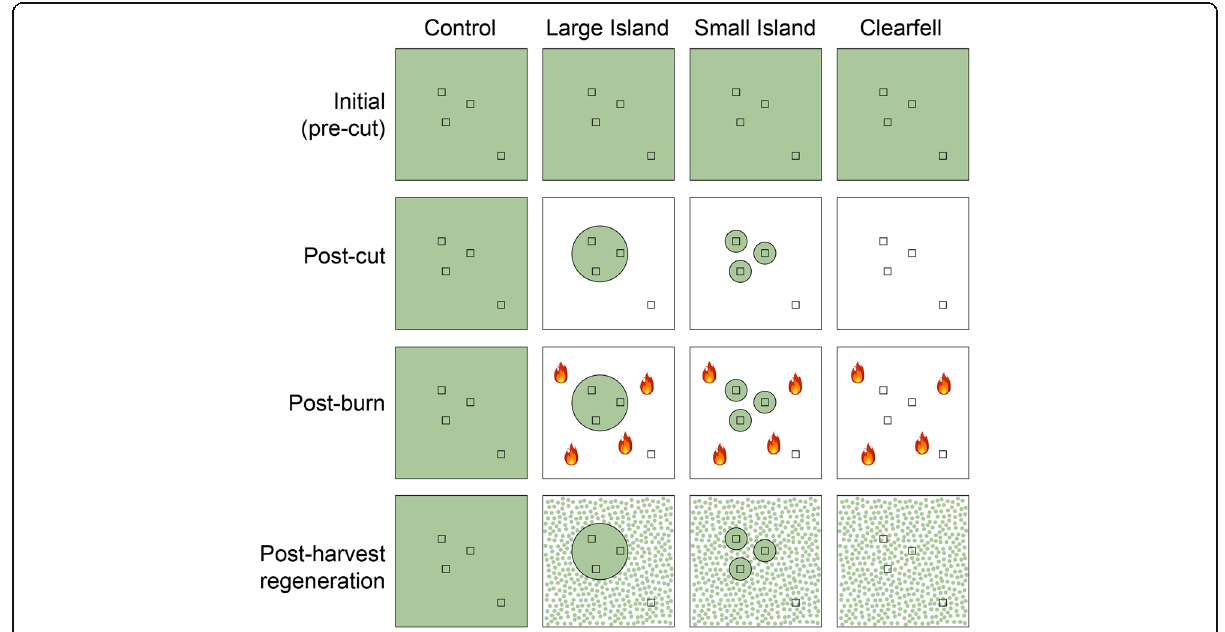
Fig. 1 The design of the variable retention harvesting experiment (modified from Lindenmayer et al. 2010). The plot outside the harvest areas is one of the external control plots in the study design (see